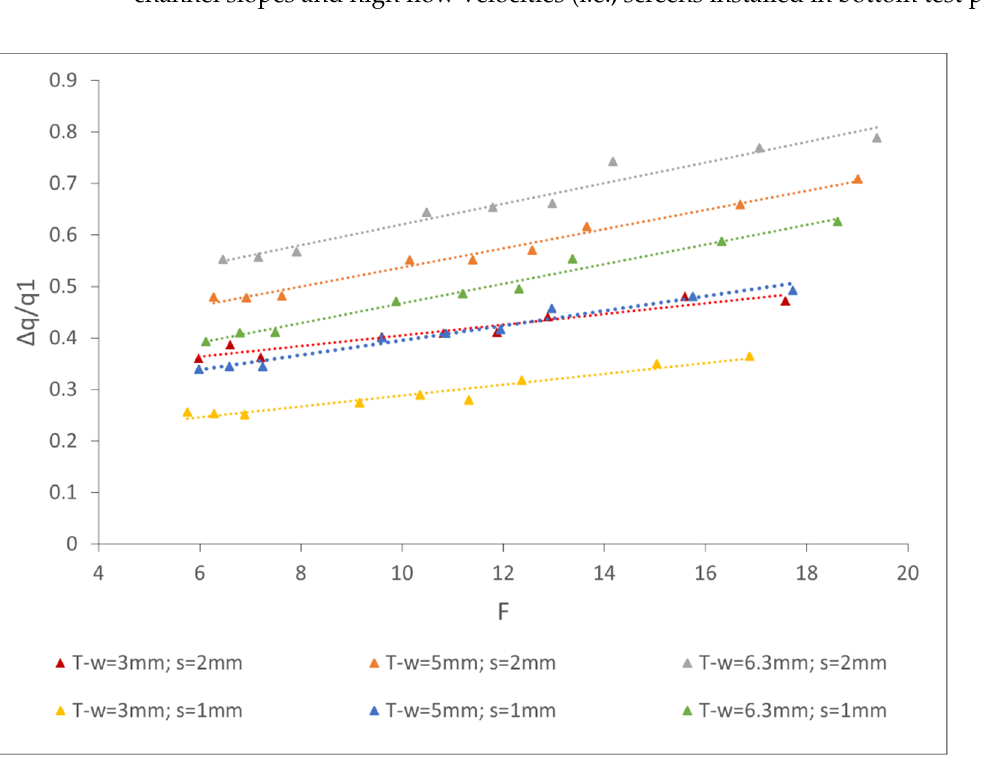
Figure 14. Relations for triangular wire screen between Δ q / q 1 and Froude number .